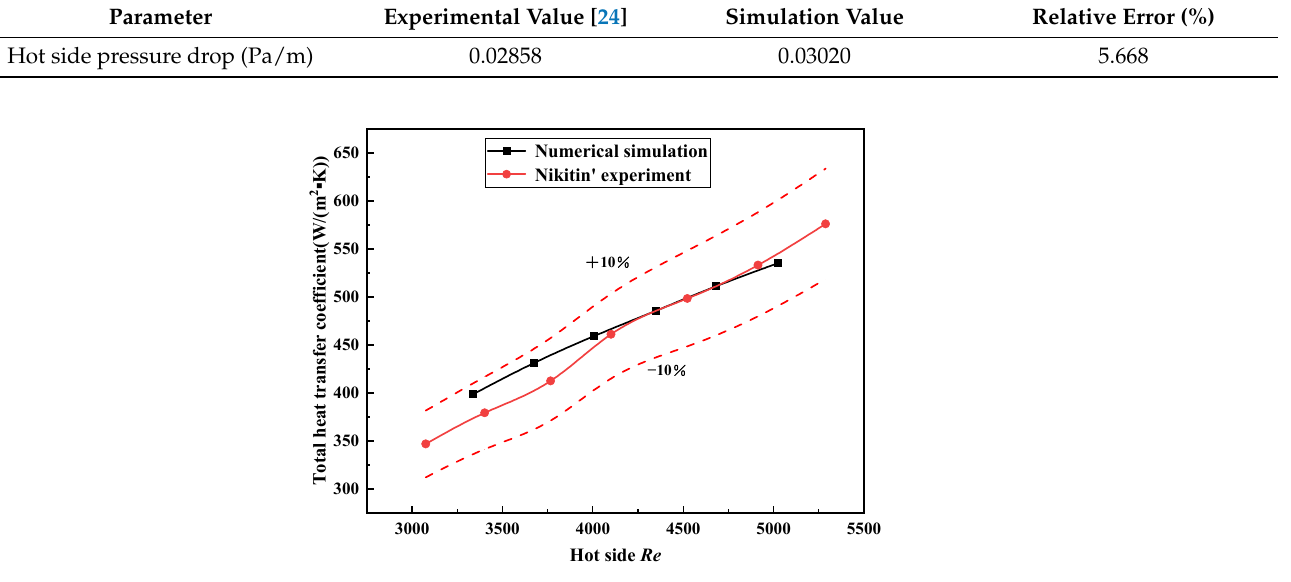
Figure 7. Comparison of simulated and experimental values of total heat transfer coefficient with Reynolds number.